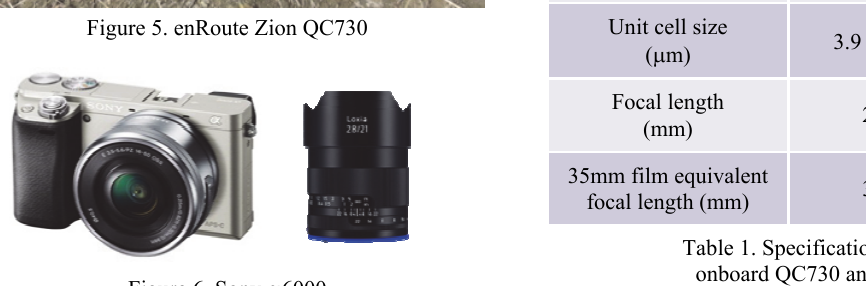
Figure 6. Sony  6000